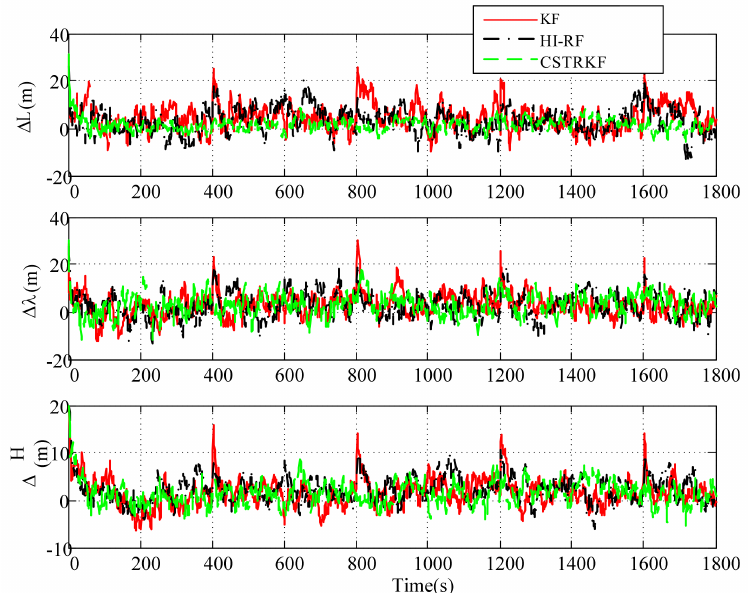
Figure 5. Position error of the INS / SRS / CNS integrated system with di ff erent filters under the condition of measurements with